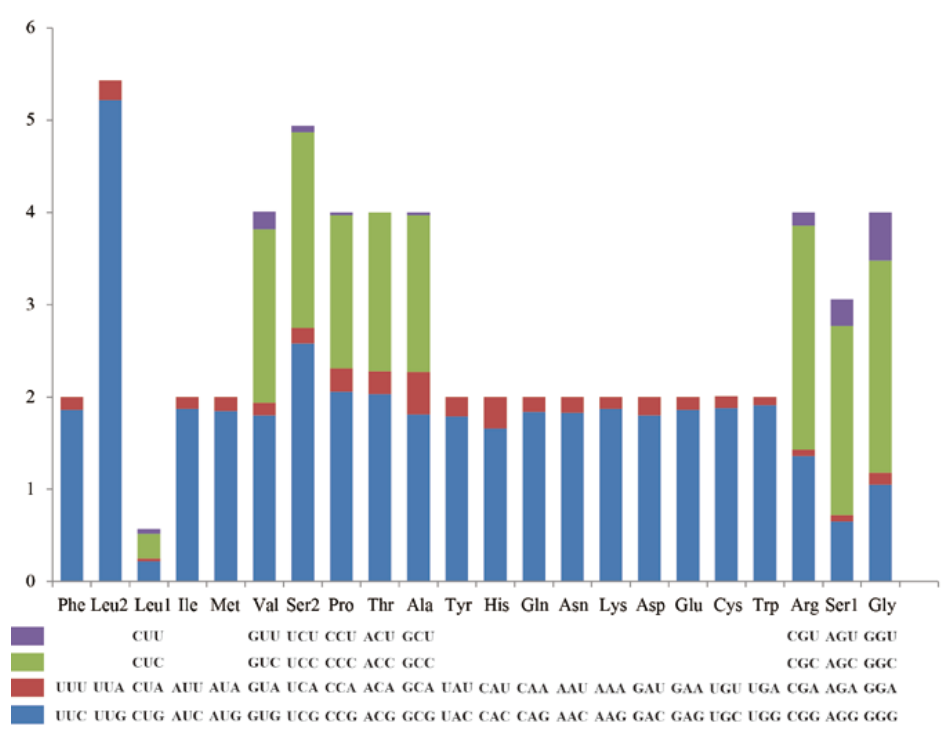
Figure 2. Relative synonymous codon usage (RSCU) of mitogenome of Luperomorpha xanthodera . Codon families are depicted in boxes below the x -axis; the box colors represent the stacked columns; and the values of RSCU are shown on the y -axis.